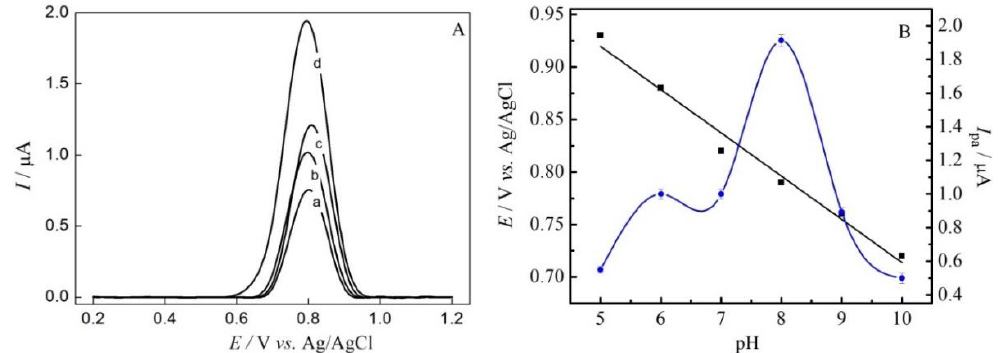
Figure 8. ( A ) Comparison of the DPV experiments for 5.0 µ mol L − 1 of SMZ in di ff erent support electrolytes, keeping the pH 8.0 and the ionic strength of 0.2 mol L − 1 for: (a) Tris(hydroxymethyl) aminomethane, (b) Britton-Robinson, (c) Acetate and (d) PBS. ( B ) E ff ect of pH on the peak potential ( (cid:4) ) and peak current ( (cid:8) ) for SMZ oxidation on the GC / rGO-AuNPs composite electrode using 0.2 mol L − 1 PBS containing 5.0 µ mol L − 1 of